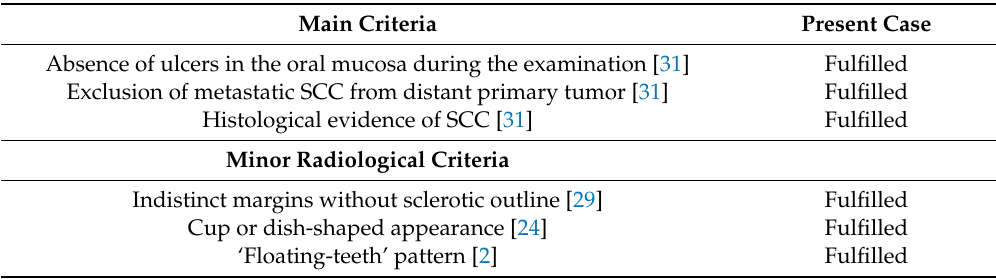
Table 3. Diagnostic criteria of